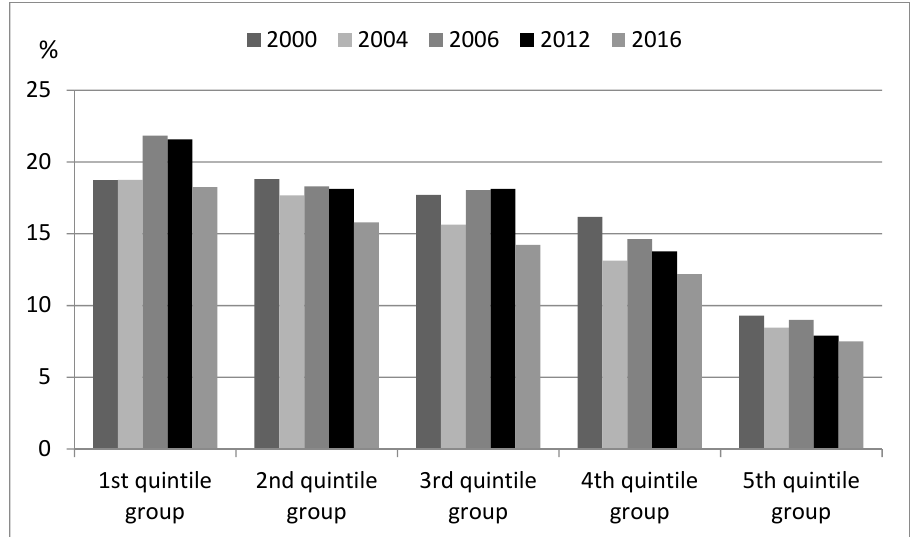
Figure 5. Share of expenditure on energy carriers in available income in one-person households in selected years 2000–2016 in Poland. Comment: The group of one-person households was divided into five equal groups according to the level of available income. In the 1st quintile group there were 1/5 of one-person households with the lowest level of available income, and in the 5th group 1/5 households with the highest level of available income. Source: own study and calculations based on CSO data.